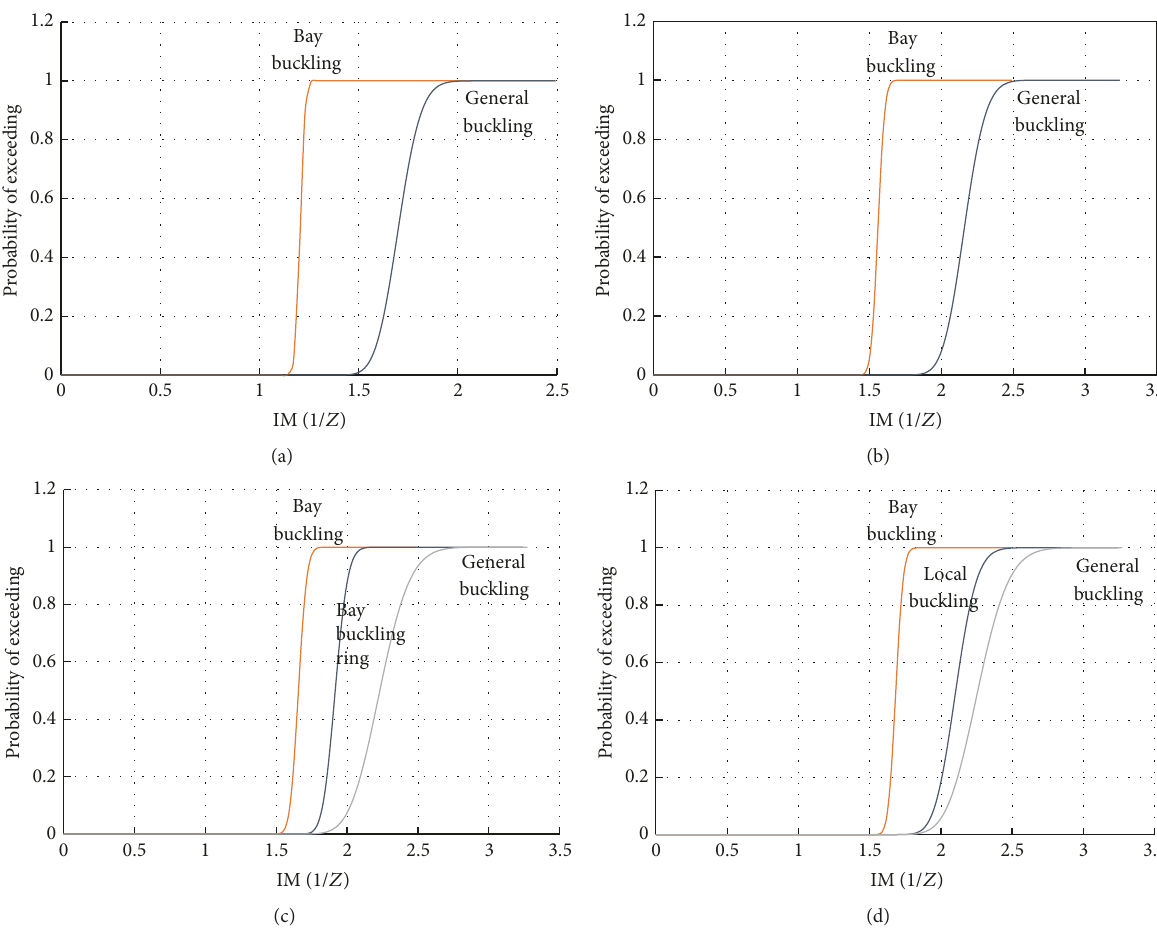
Figure 12: Fragility curves of cylindrical shells with distinct limit states: (a) unstiffened shell, 4mm; (b) unstiffened shell, 6.5 mm; (c) ring- stiffened shell, 6.5 mm; and (d) ring- and longitudinal-stiffened shell, 6.5